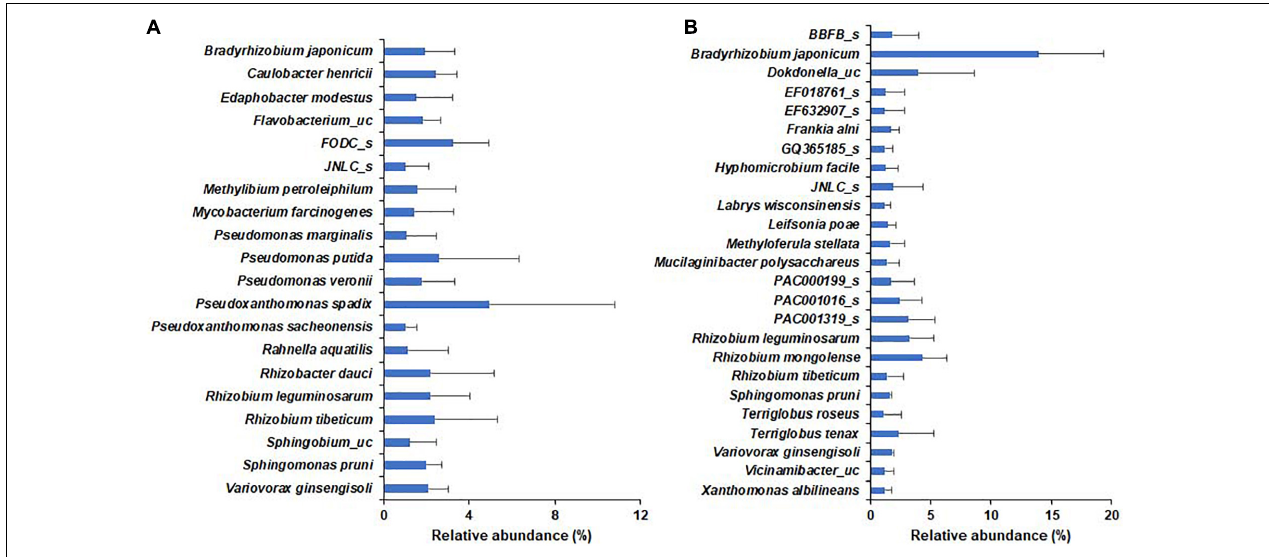
FIGURE 5 | Relative abundance of bacterial species within the roots of long-sepal Donggang pasque-flower plants. The bacterial species with relative abundance > 1% in roots of Donggang pasque-flower plants were compared between wild (A) and cultivated (B)